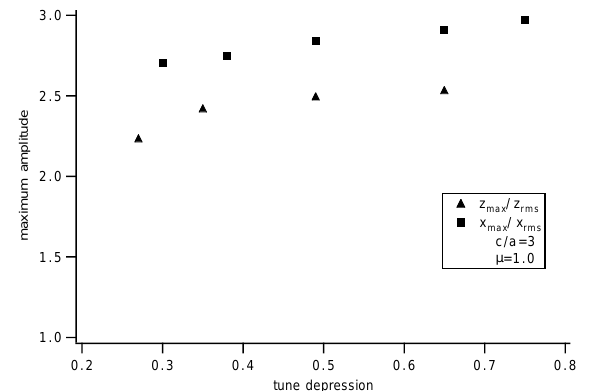
FIG. 8. The maximum particle amplitude in transverse and longitudinal directions vs transverse or longitudinal tune de- pression for an rms matched uniform distribution.